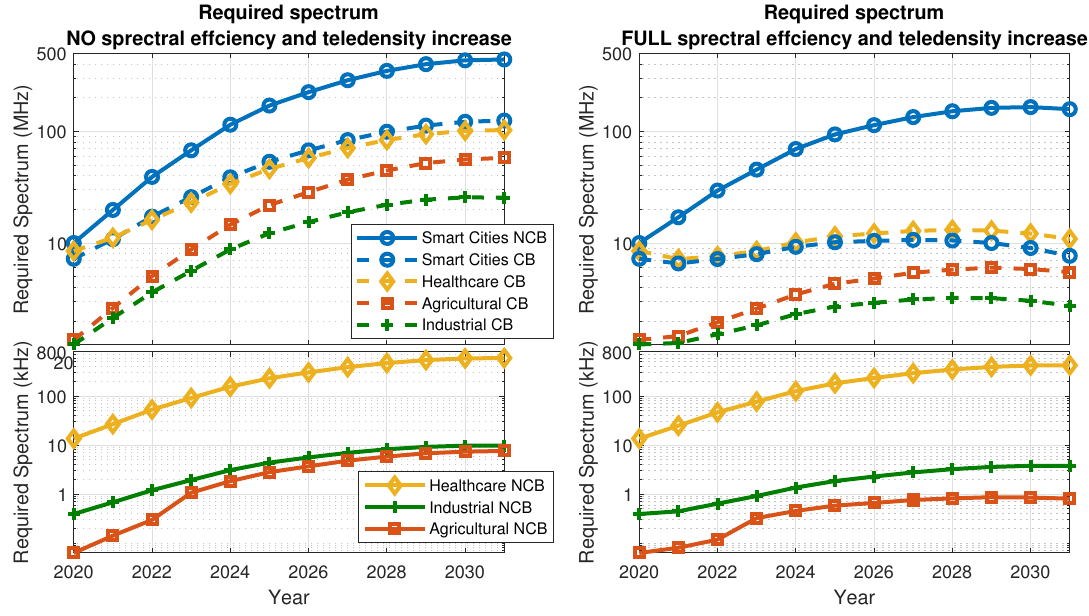
Figure 4. Cellular band (CB) and non-cellular band (NCB) requirements per economic